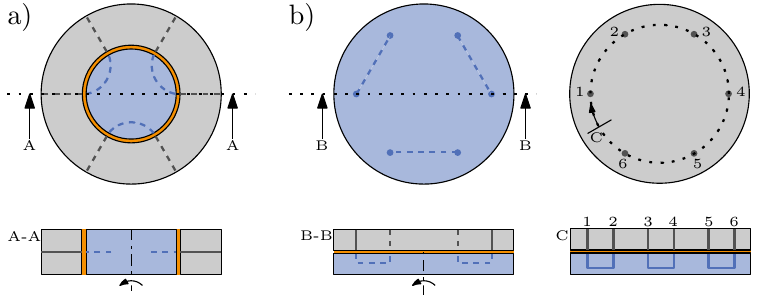
Figure 1. Schematic top and section view of a 6-port injection valve with radial compression ( a ) and axial compression ( b ). Rotor is shown in blue, stator in gray, and sealing gap in orange. For the axial compressed valve, an additional circular sectional view (C) is given, displaying interconnections of rotor and stator along dotted circle. To achieve tightness, additional parts are needed for compression with axial